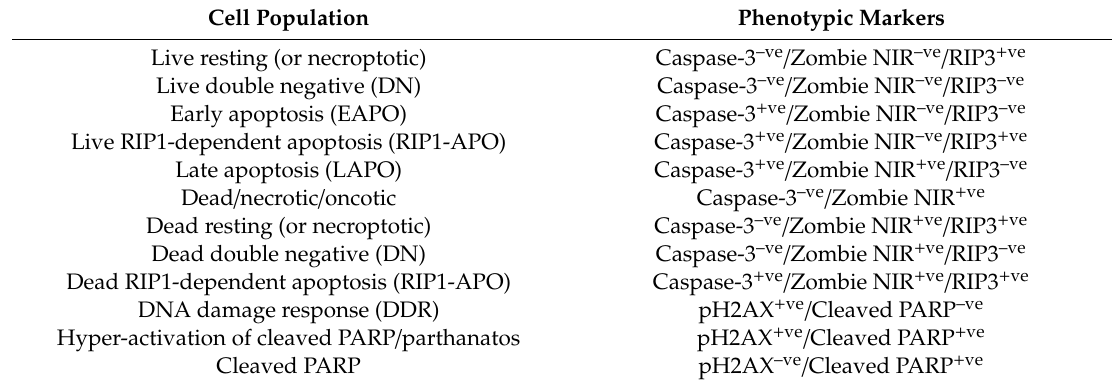
Table 1. Cell description and phenotypes; Figure S1 provides a diagrammatical